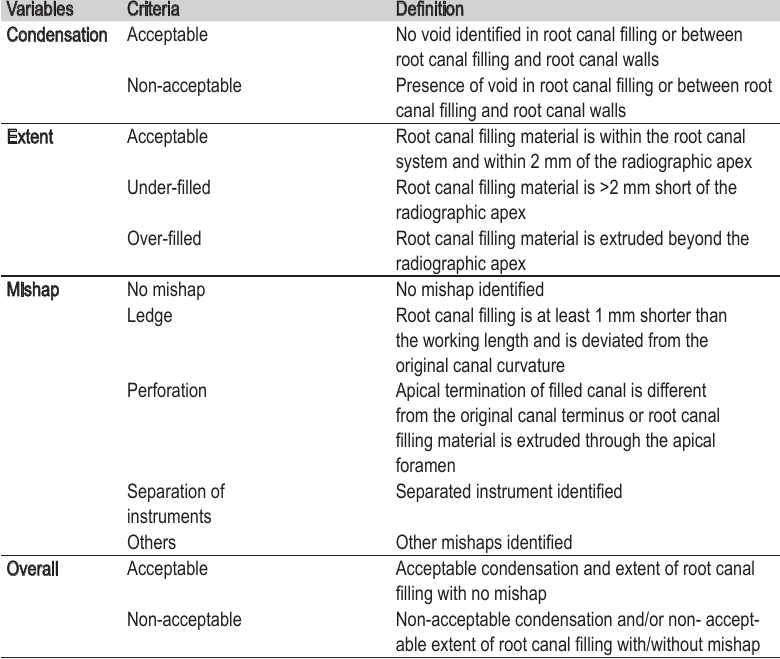
Table 1 - Criteria used to assess technical quality of root canal